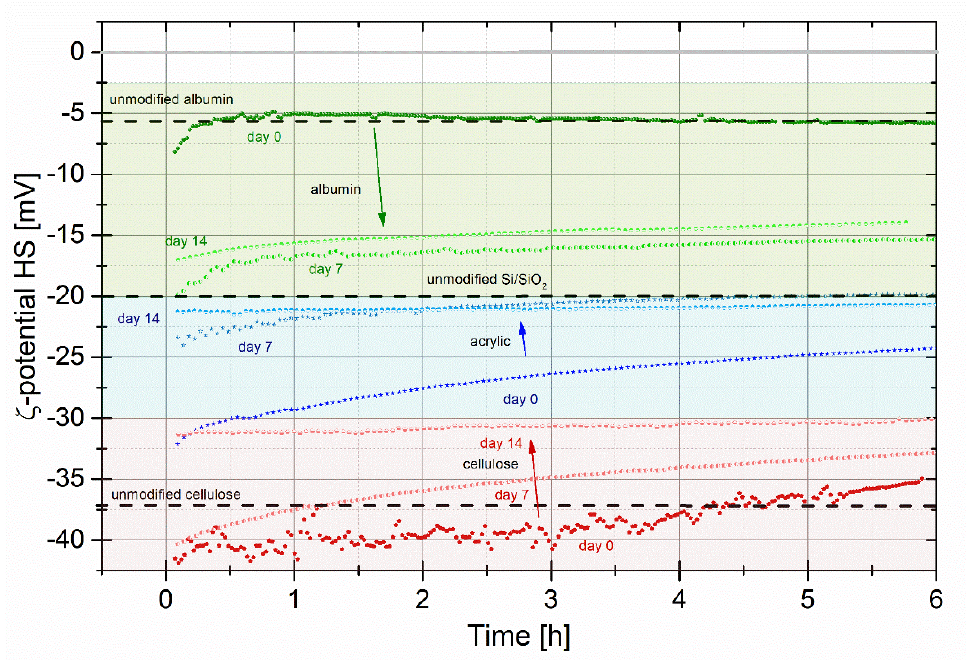
Figure 1. ζ -potential stability tests (measured in 1 mM KCl at a pH of 5.5 ± 0.2) of Si / SiO 2 samples with composite films of albumin (green), cellulose (red), and acrylic polymer (blue) mixed with 0.45 wt.% nanotubes. The first measurement for each composition (day 0) is performed with fresh samples, samples were stored in 1 mM KCl solution for 1 week, and then, before each following experiment (day 7 and day 14, respectively). Arrows mark the propagation of the behavior for sequential measurements. Dashed lines indicate values for unmodified albumin, cellulose, and Si / SiO 2 .